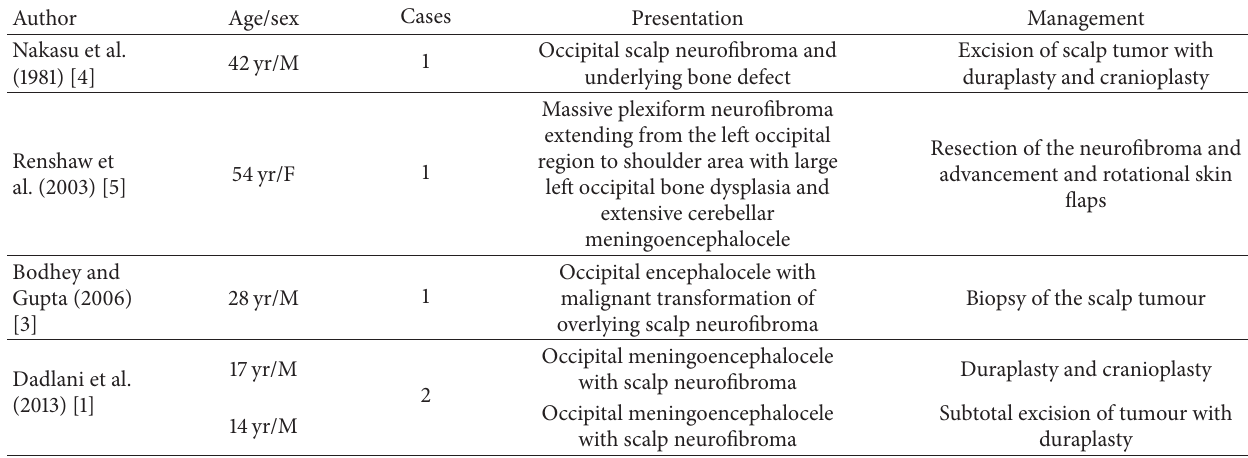
Figure 1: Clinical photo of the plexiform neurofibroma and cafe au lait spots (a). Axial T1 (b, f), coronal T1 (c), coronal T2-weighted (d), and sagittal T1-weighted (e) MR images showing occipital meningoencephalocele (black arrow) and parapharyngeal meningocele (hollow arrow). Table 1: Previously reported cases of occipital meningoencephalocele in